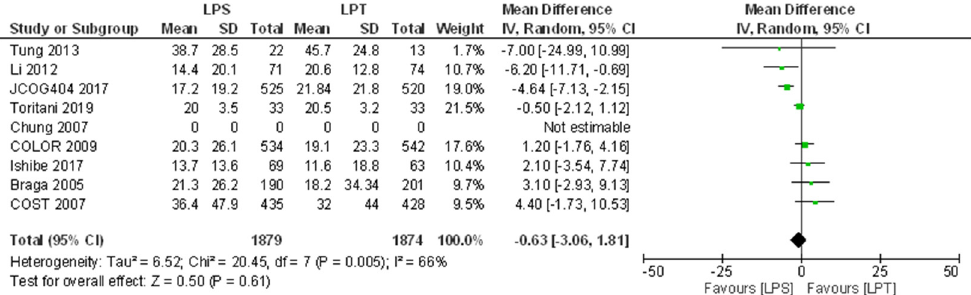
Figure 3. Forest plot of comparison: Mean difference for the disease-free survival. LPS: laparoscopic approach; LPT: open approach (laparotomy).